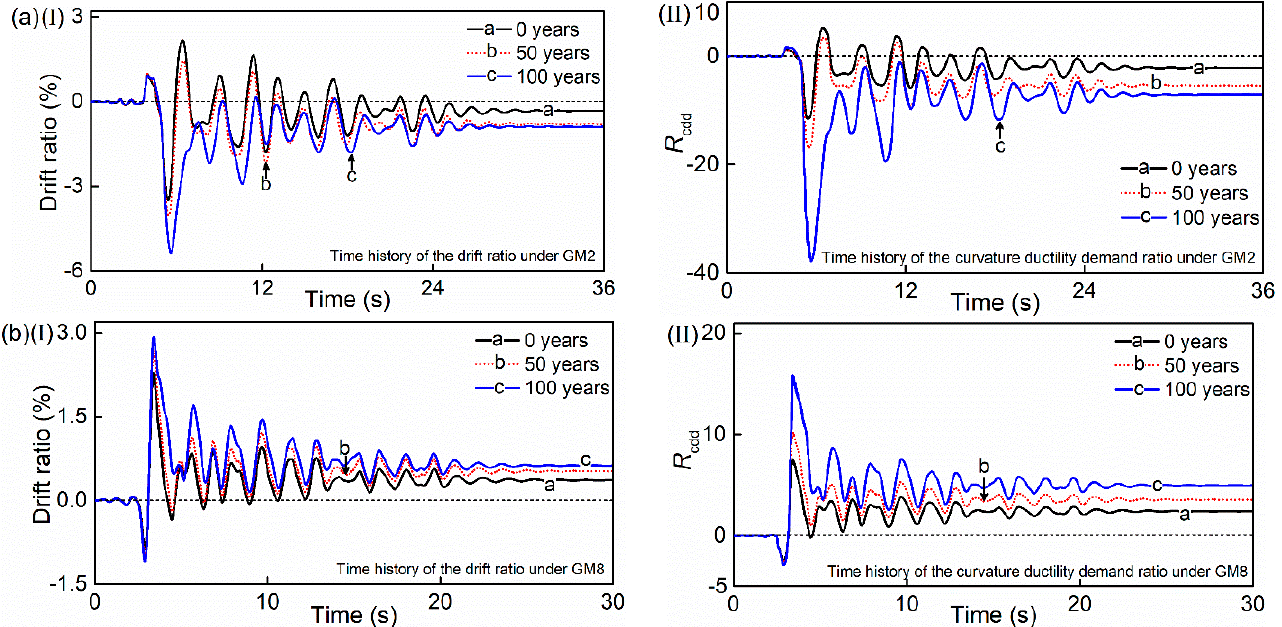
Figure 17. Time-dependent time histories of the drift ratio and curvature ductility demand ratio under the excitation of: ( a ) GM2; ( b ) GM8.